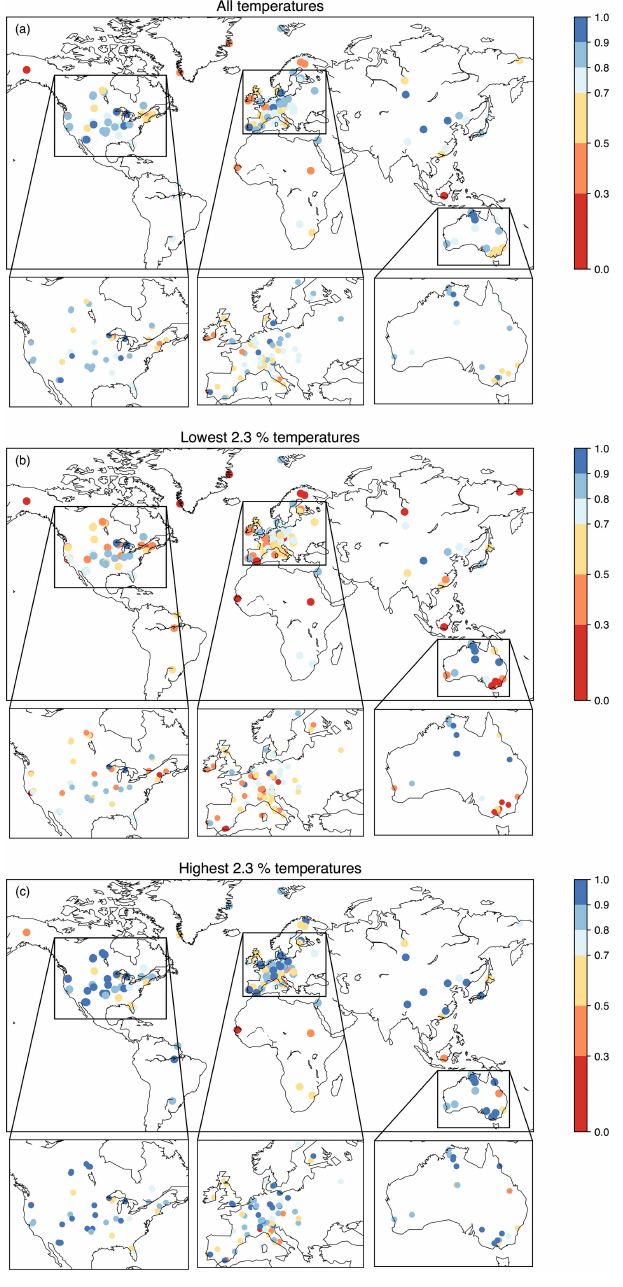
Figure 3. Maps of Q h measurement ratios. Panel (a) shows the Q h measurement ratios for the overall temperature distribution, (b) for the lower extreme and (c) for the upper extreme. Each dot on the map represents a flux tower site.